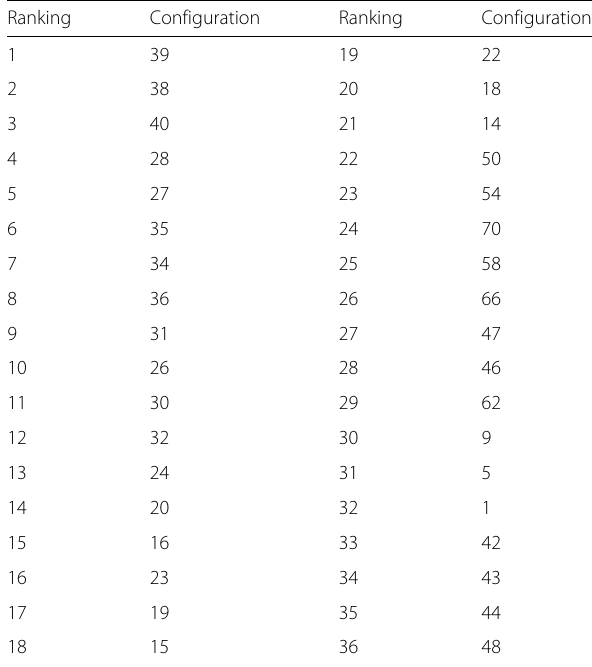
Table 12 Configuration ranking for the defined criteria (i.e.